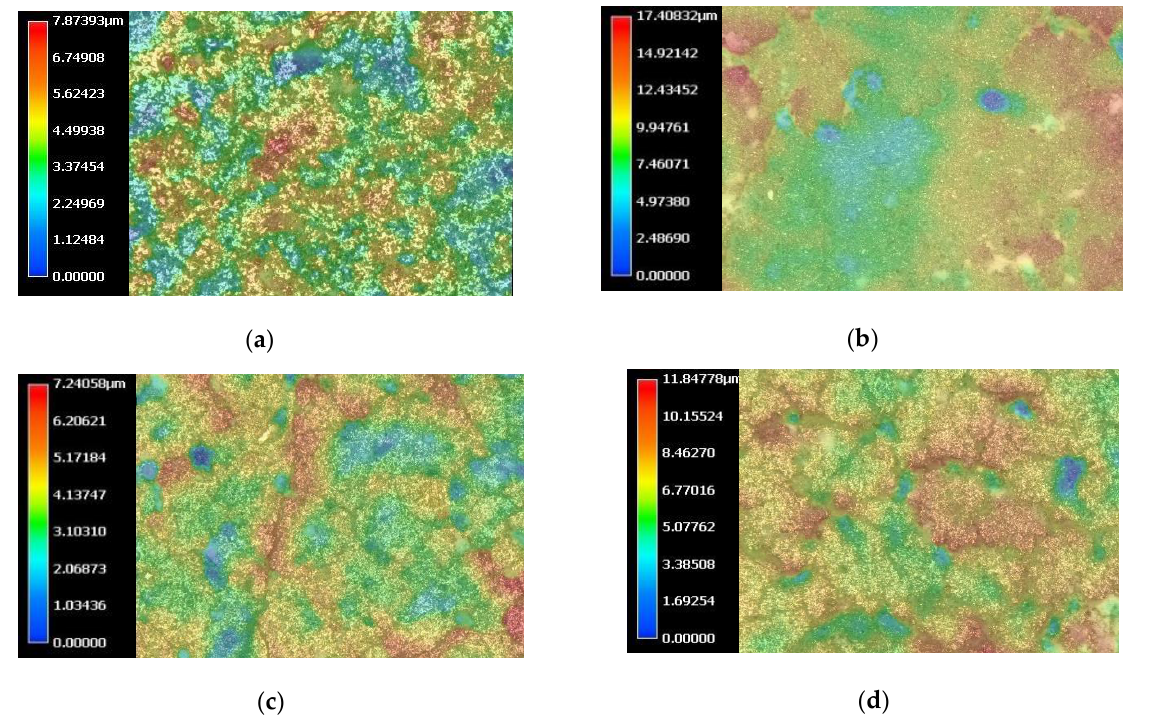
Figure 5. Color 3D map of Biodentine surface ( a ) of the 45-min setting sample after 5 min irrigation with CA, ( b ) of the 45-min setting sample after 20 min irrigation with CA ultrasonically activated, ( c ) of the 24-h setting sample after 5 min irrigation with CA and ( d ) of the 24-h setting sample after 20 min irrigation with CA ultrasonically activated.